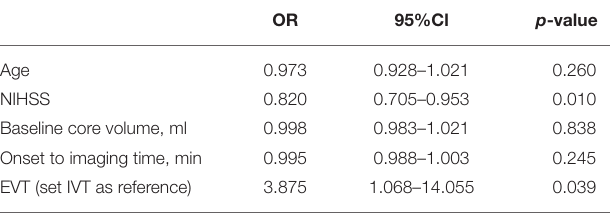
TABLE 3 | Multivariate regression analysis of independent predictors for good outcome (mRS < 3). OR 95%Cl p -value